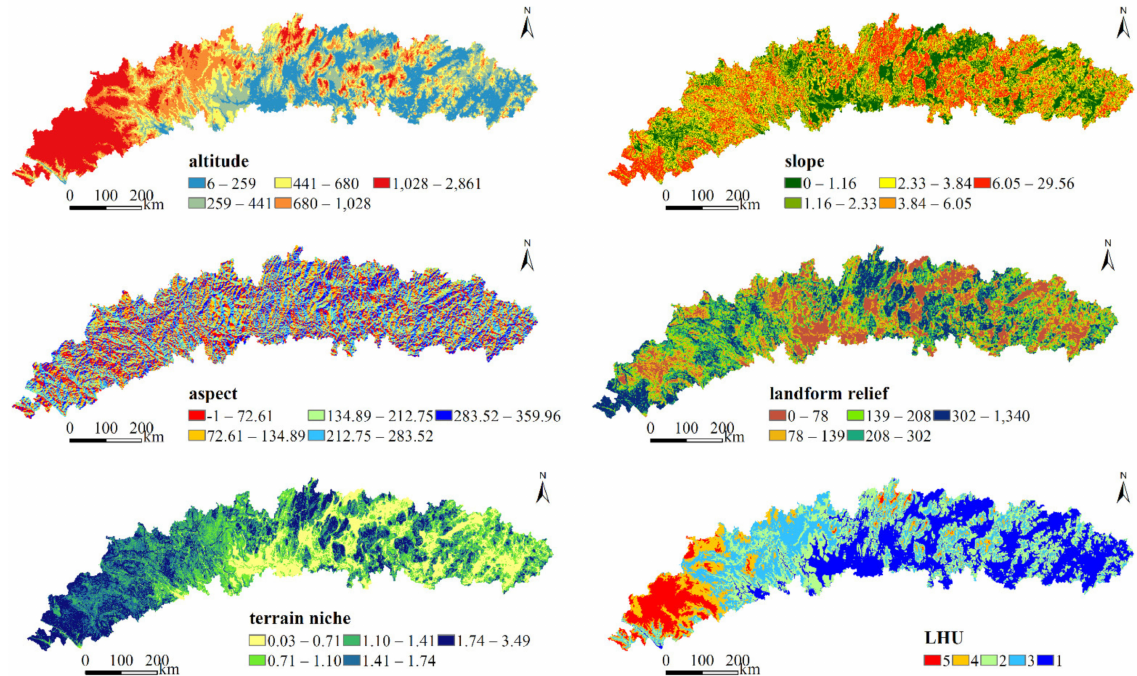
Figure 3. Spatial distribution of terrain gradients and